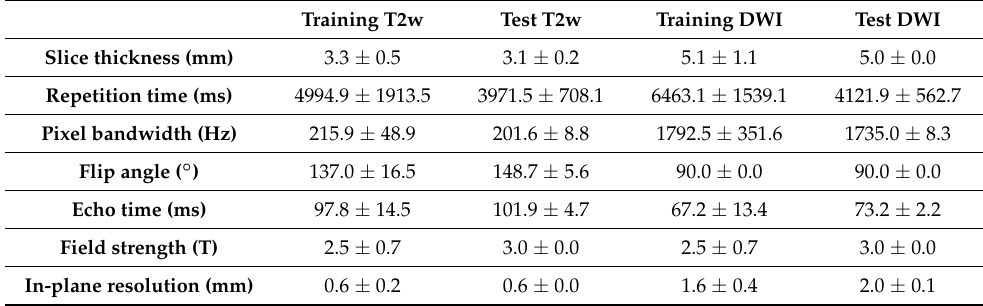
Table 3. Differences between the training and test